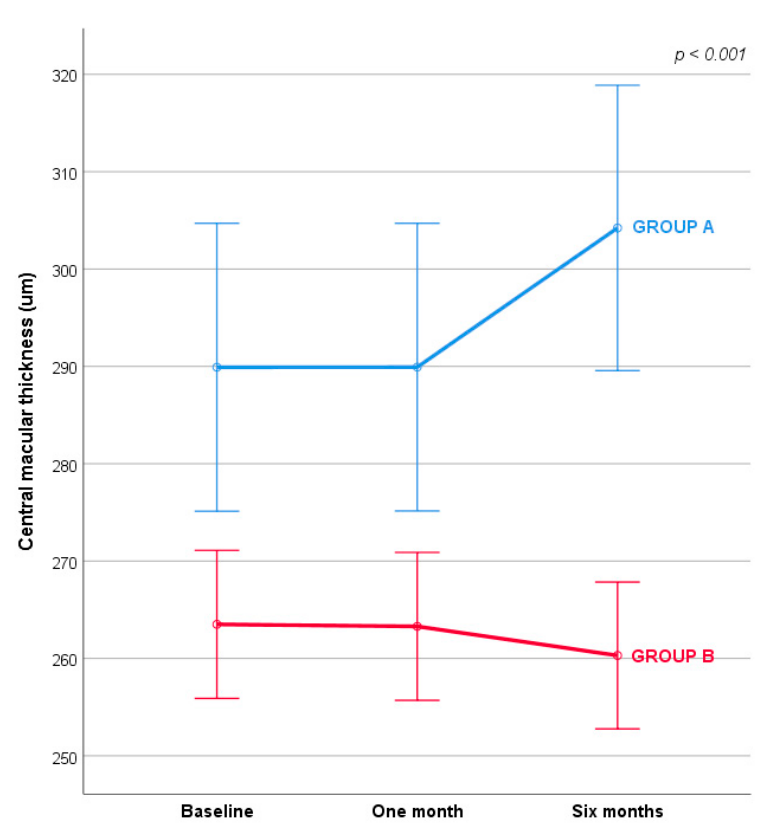
Figure 1. Central macular thickness changes over time. Covariates appearing in the model are evaluated at the following values: Age, years = 63.697, T 0 Visus = 53.377. Error bars: +/ − 1 SE. After the first month of treatment both groups remained mostly stable. After six months there was a significant difference between the groups: Group B in particular remained unchanged compared to Group A, which showed a worsening in CMT dimension. The interaction between time and treatment on BCVA was also significant, F (1.084, 108.386) = 12.514; η 2 = 0.111; p < 0.001, indicating that the change in BCVA among groups was significantly different (Table